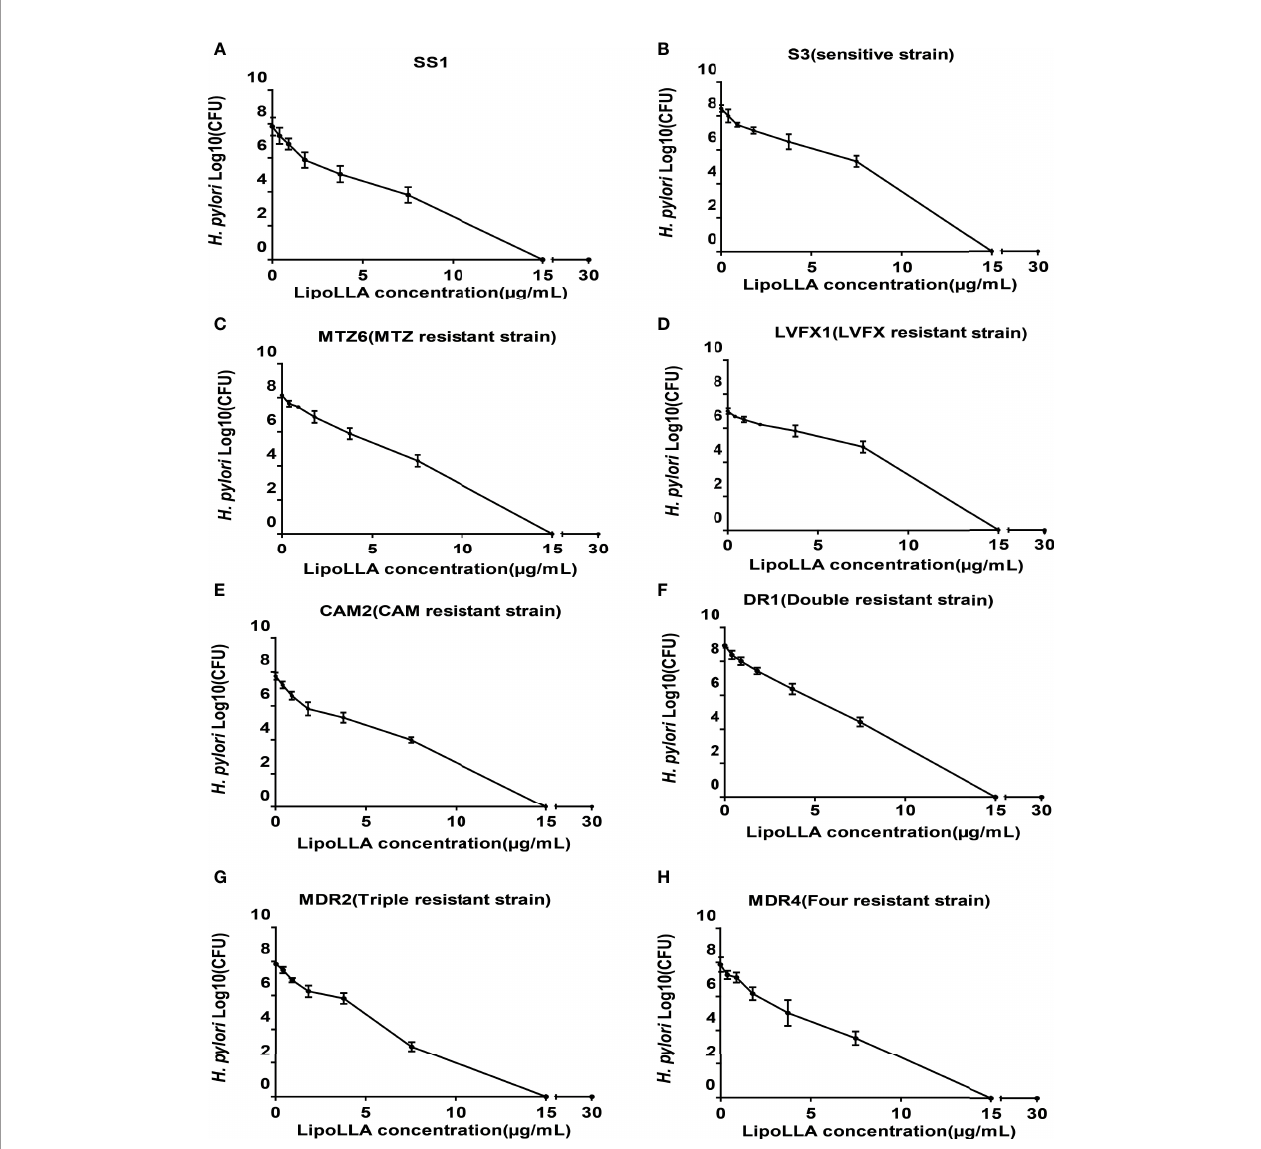
FIGURE 2 | Concentration sterilization curves of LipoLLA against H. pylori strains with different drug resistance. Eight H. pylori strains were co-cultured with LipoLLA respectively to observe the antibacterial activity of LipoLLA against H. pylori with different drug resistance. (A) Concentration sterilization curves of LipoLLA against SS1. (B) Concentration sterilization curves of LipoLLA against sensitive strain S3. (C) Concentration sterilization curves of LipoLLA against MTZ-resistant strain MTZ6. (D) Concentration sterilization curves of LipoLLA against LVFX-resistant strain LVFX1. (E) Concentration sterilization curves of LipoLLA against CAM-resistant strain CAM2. (F) Concentration sterilization curves of LipoLLA against dual drug-resistant strain DR1. (G) Concentration sterilization curves of LipoLLA against triple drug-resistant strain MDR2. (H) Concentration sterilization curves of LipoLLA against quadruple drug-resistant strain